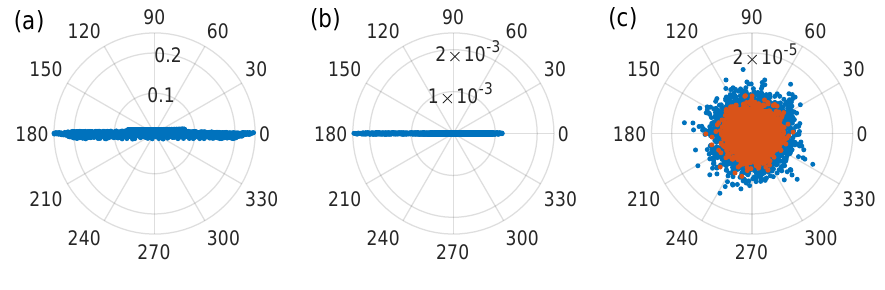
Figure 4. Interferogram constellations A c [ k ] exp ( − j θ ) after in-phase demodulation and rotation of: ( a ) a flat fiber end; ( b ) a 10-km SMF Rayleigh backscattering; and ( c ) system’s noise level when the RF signal is turned off but the optical source is on (blue), and when both RF and optical sources are off (orange), also for a 10-km SMF spool. The number of points in each constellation, or number of I-OFDR frequency steps f k , is 5000.